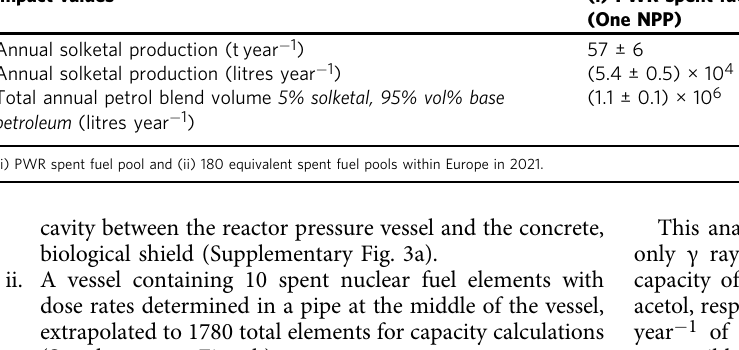
Table 1 Impact values of solketal production on transport fuels. Impact